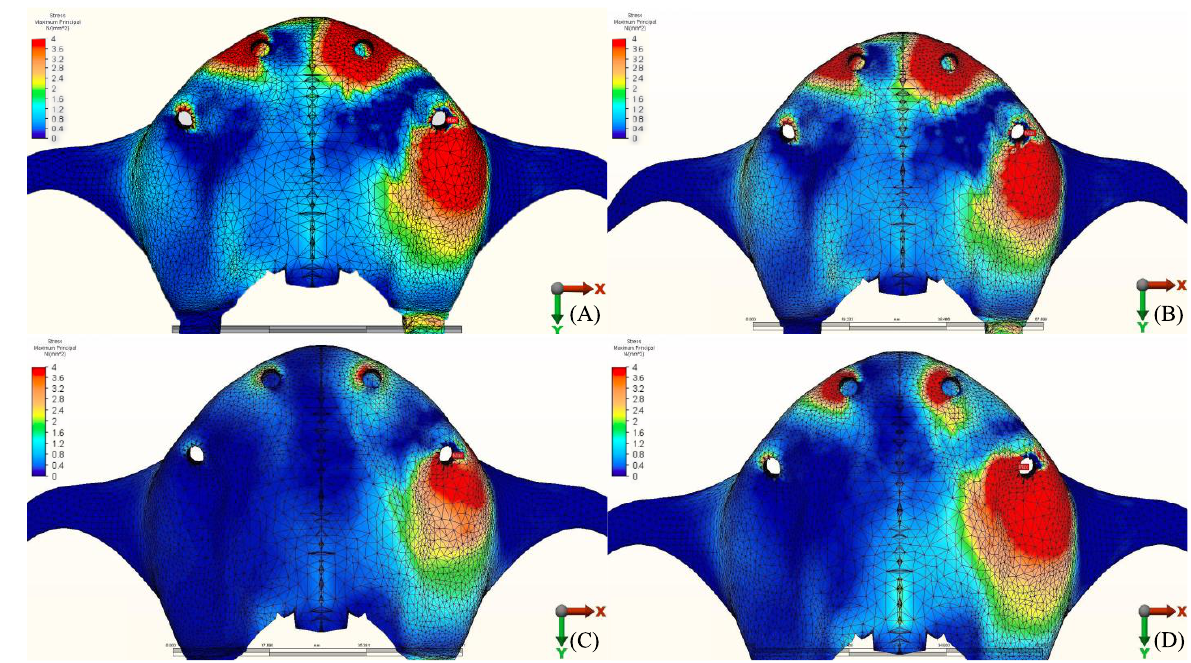
Figure 5. Pmax stress distribution in cortical bone for group 1, titanium bar with acrylic teeth. ( A ) Model 1.1, opposing natural tooth. ( B ) Model 1.2, opposing tooth-supported full ceramic crown. ( C ) Model 1.3, opposing acrylic prosthesis with titanium framework. ( D ) Model 1.4, opposing implant-supported full ceramic crown.